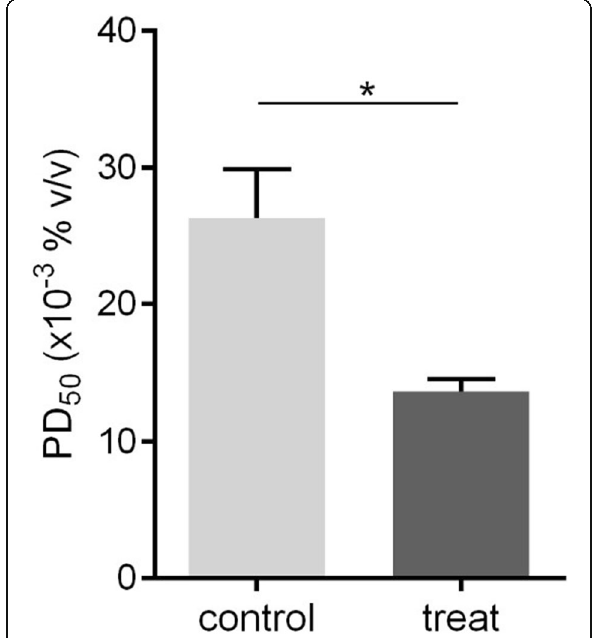
Fig. 7 PD 50 values for crickets injected with piperidine alone (control) and piperidine plus the rSol g 4.1 protein (treatment). The graph shows the means ± SEM for different percent dilutions of piperidine in the PD 50 assay. *Values were significantly different from the control at p <